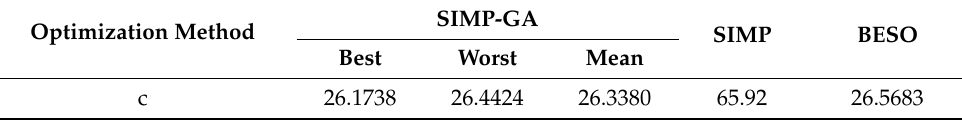
Table 3. Comparison of half-wheel beam optimization